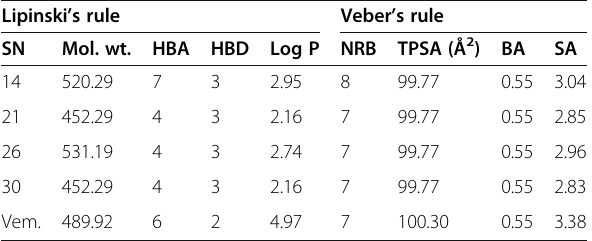
Table 5 Drug-likeness parameters including bioavailability (BA) and synthetic accessibility (SA) of the selected compounds Lipinski ’ s rule Veber ’ s